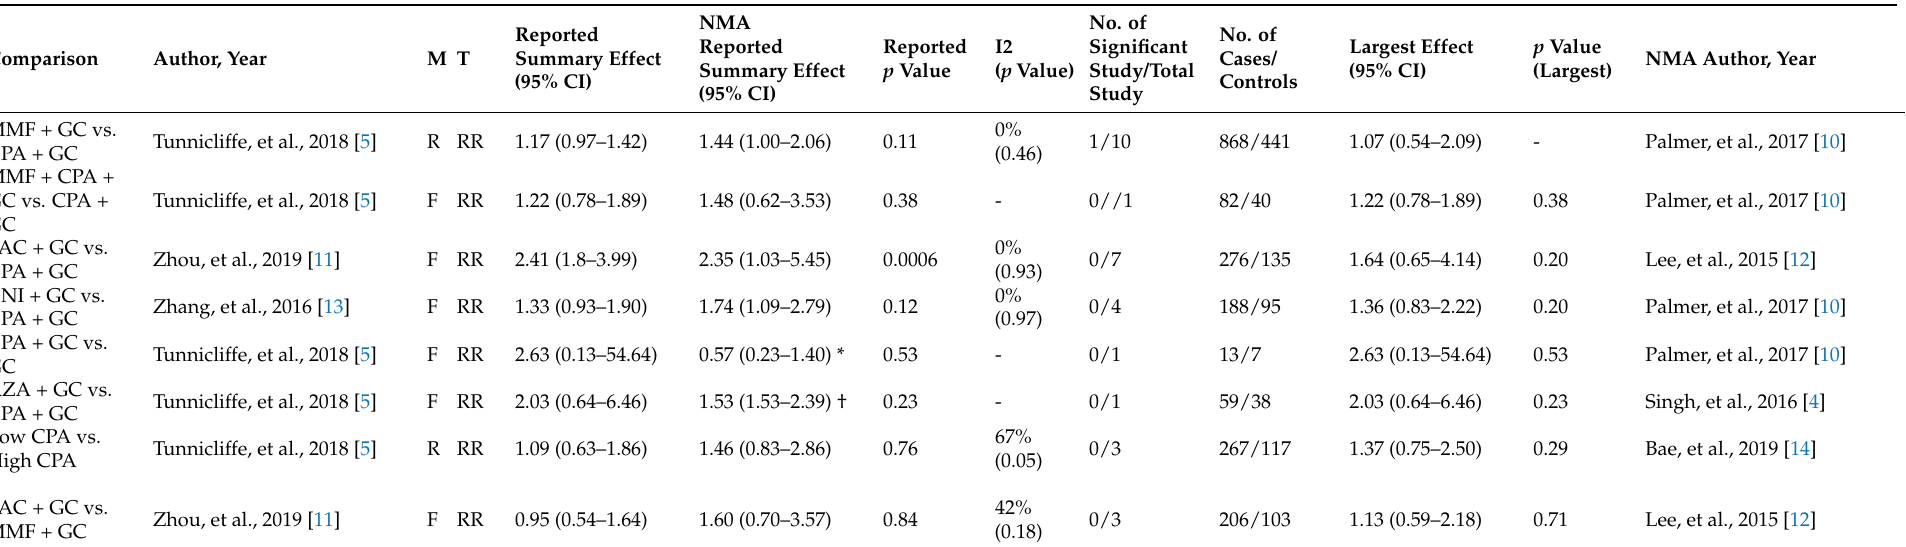
Table 1. Remission rates after induction therapy in lupus nephritis (comparison of the results between conventional meta-analysis and network meta-analysis).